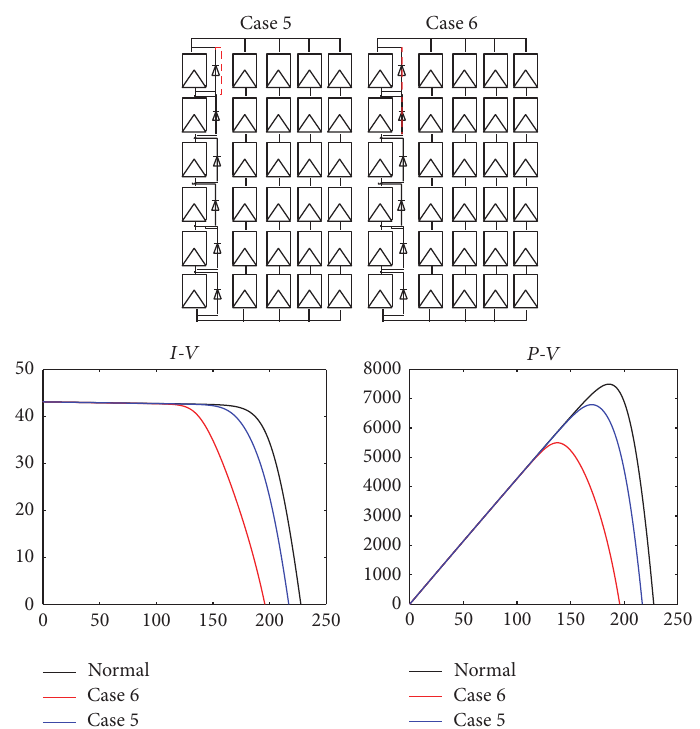
Figure 6: The PV array configuration for bypass diode short circuit.